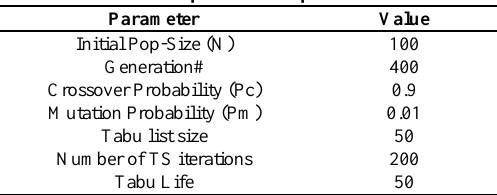
Table 1. Experimental parameters.